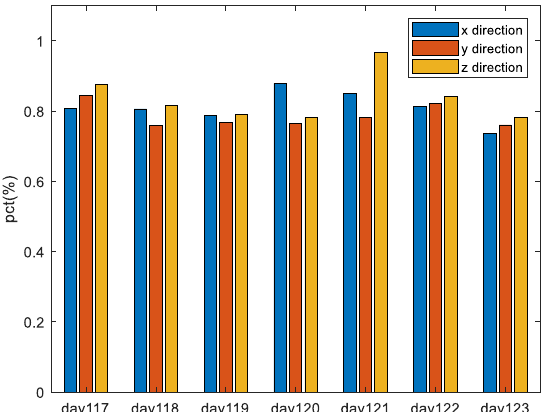
Figure 9. The probability that the MPO tolerable maximum deviation X max_mpo is greater than the PO X max_po . It shows that the MPO method has stronger robustness to “large deviations”, with a probability of more than 70%.